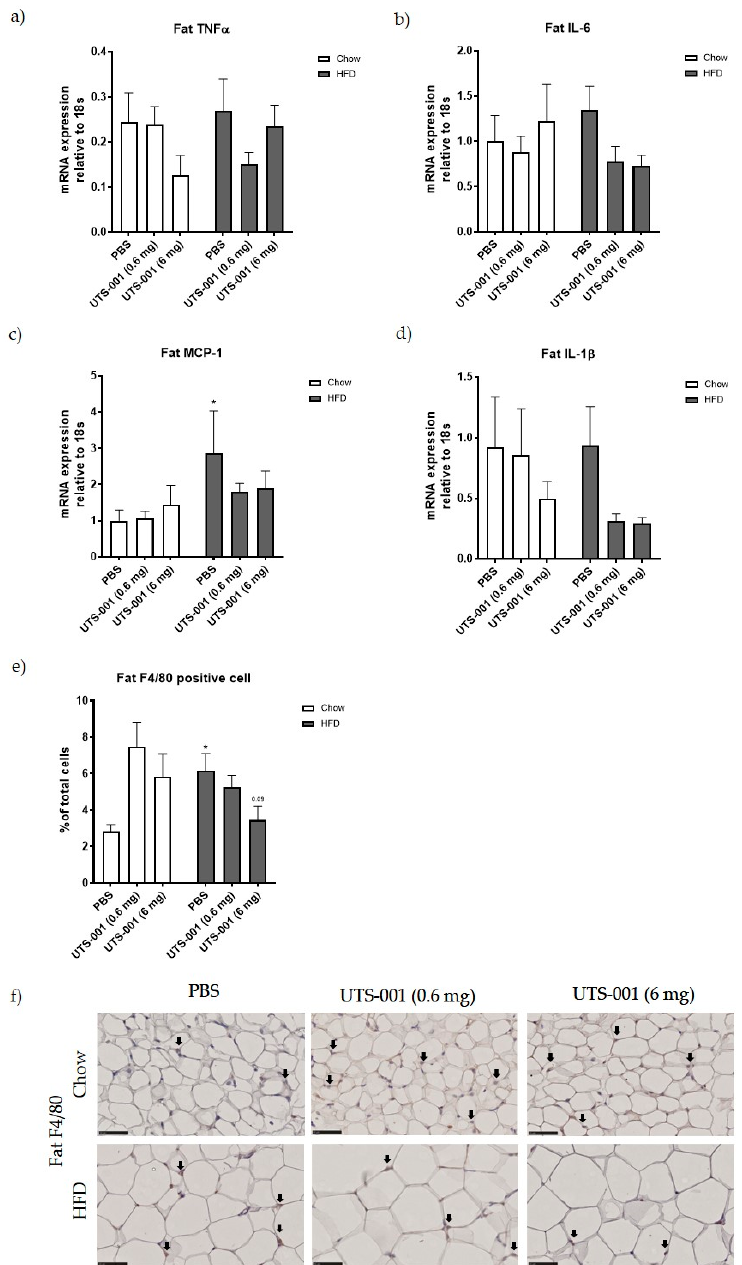
Figure 3. Fat mRNA expression of ( a ) TNF- α , ( b ) IL-6, ( c ) MCP-1, ( d ) IL-1 β and ( e ) Percentage of macrophage number in the fat as identified by F4/80 immunohistochemistry and ( f ) Respective representative images for the stain taken at 10× magnification. Positive staining indicated by arrows in figure f. Data are represented as mean ± S.E.M and were analysed using two-way ANOVA followed by post hoc Fisher’s LSD test, n = 6–9. * p < 0.05 vs. Chow-PBS.